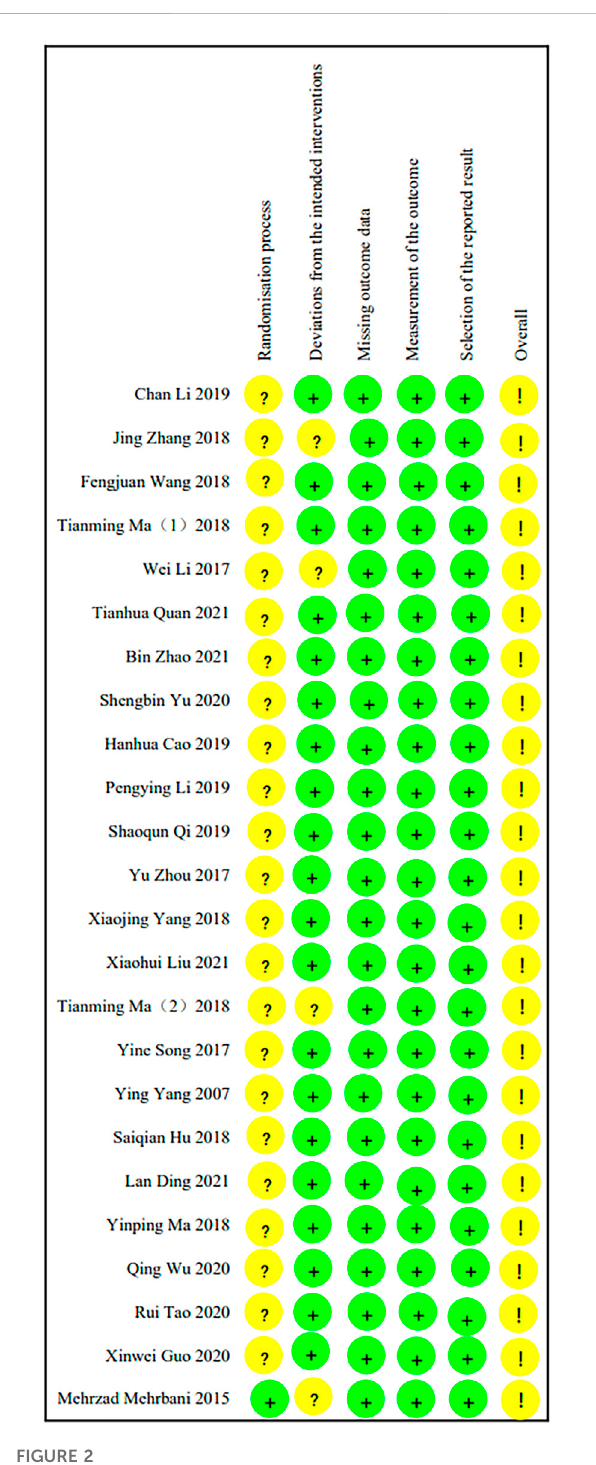
FIGURE 2 The results for the evaluation of the selected articles using